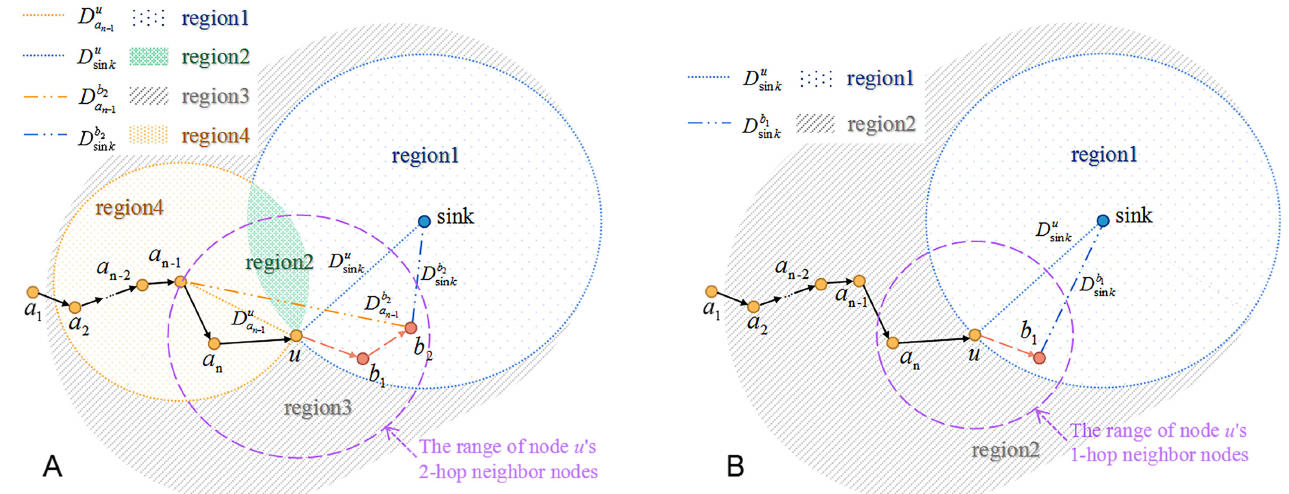
Figure 6. The greedy forwarding mechanism is expressed in the form of probability. ( A ) The greedy forwarding mechanism of THECB: According to the distance, the nearby region around the current forwarder u is divided into four parts: region1, region2, region3, and region4. The specific division rule is expressed in Equation (6). b 2 is the node that may be selected as the next 2-hop node by u . The distance from b 2 to the sink ( D b 2 ) is shorter than the distance from u to the sink ( D u ); The sink sink distance from b 2 to a n − 1 ( D b 2 a ) is longer than the distance from u to a n − 1 ( D u a ), which means b 2 is n − 1 n − 1 in region1, and is nearer to the sink and farther to the upstream forwarders than u . ( B ) The traditional greedy forwarding mechanism: The nearby region around the current forwarder u is divided into two parts. The neighbour node in region1 is closer to the sink than the current forwarder, while the neighbour node in region 2 is farther to the sink than the current